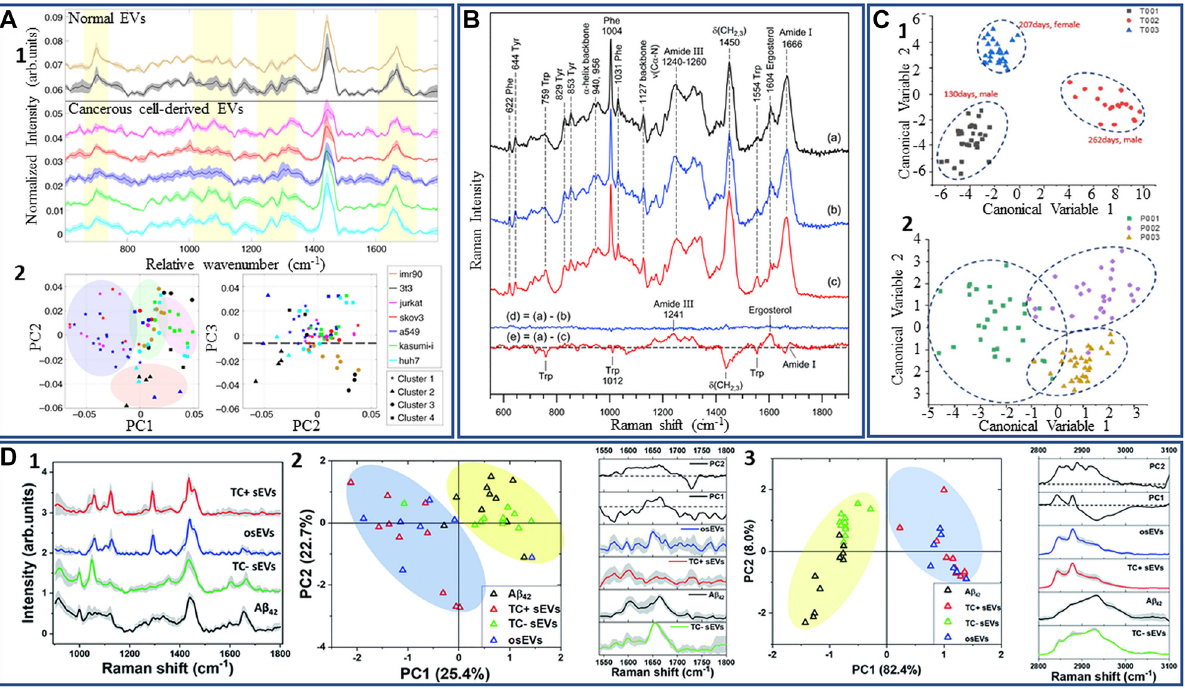
Figure 4: Label-free Raman characterization of EVs. (A) Differences betweennormalandcancer-cell derivedsingle EVsobtainedwith Ramantweezermicrospectroscopy;(A1)Ramanspectrafrom single EVs derived from healthy and cancerous cell lines; (A2) Scatter plot of PC1 and PC2 obtained for principal component analysis for each cell line. Cell lines are represented with different colors and cluster membership is highlighted by different shapes as shown in the legend (adapted with permission from [156]). (B) Study of Raman tweezers microspectroscopy of EVs. Differences between EVs isolated from cells treatedanduntreatedwithhepatotoxinacetaminophen(treatedcells-curveaandb,nontreatedcells – curvec),asseeninthebottomspectra (reproduced with permission from [157]). (C) Principal component analysis (PCA) – linear discriminant analysis (LDA) of the EVs obtained from peripheralmononuclearbloodcells(P001,P002,andP003)andtrophoblastcells(T001,T002,andT003);(C1)PlotsoftrophoblastderivedEVs from three different bovines; (C2) Plots of PBMC-derived EVs from three different bovines (adapted with permission from [158]). (D) Investigationofamyloidbeta(A β 42 )presenceinthemolecularcargoof EVsisolatedfromADcellculturemodel;(D1)averageRamanspectraof TC-sEVs, TC + sEVs, osEVs, and A β 42 pure protein in the fi ngerprint region; (D2) Analysis of the Raman spectra of the amide I region 1540 – 1800 cm − 1 . The scatter plot of the fi rst two principal components for each EVs group; (D3) Analysis of the “ high-wavenumber region ” 2800 – 3100cm − 1 ofnormalizedRamanspectra.ThePCAscatterplotofthe fi